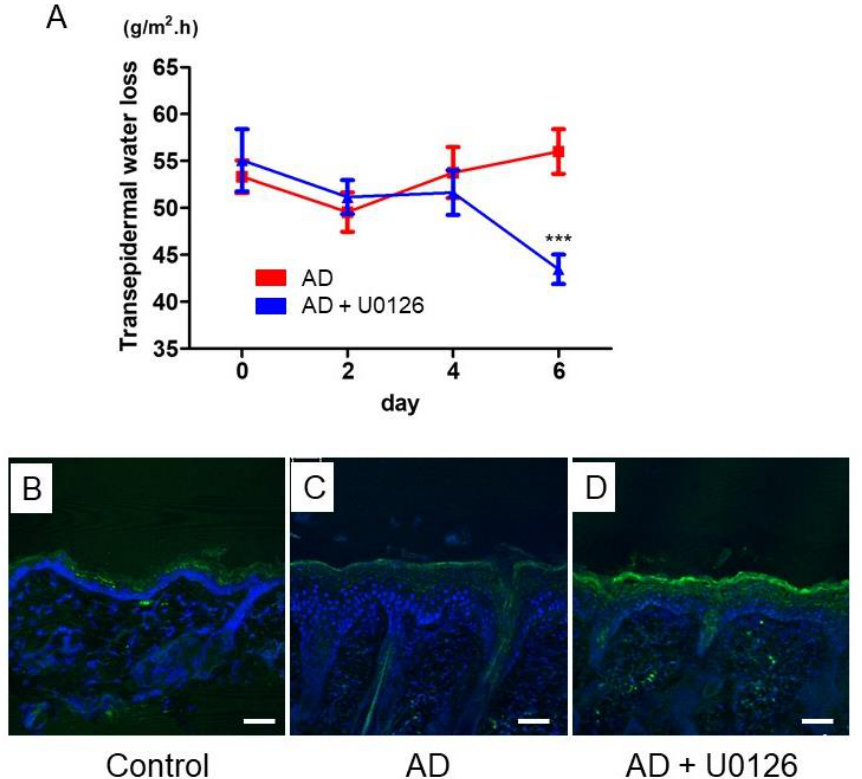
Figure 4. Topical application of ERK inhibitor improved TEWL and restored FLG expression in mite antigen-induced AD in mice. ( A ) TEWL was measured on the lesion by a Vapo Scan instrument on day 0, 2, 4, and 6. Data were presented as the average of five points repeated recordings. All data are presented as mean ± S.E.M. (n = 9 per group). *** p < 0.001 Student’s unpaired two-tailed t-test on each day. Immunohistochemical analysis of FLG protein (green) in the back skin in control ( B ), AD ( C ), AD + U0126 ( D ) groups on day 7. Nuclei were counterstained with DAPI (blue). Scale bar: 50 μ m.